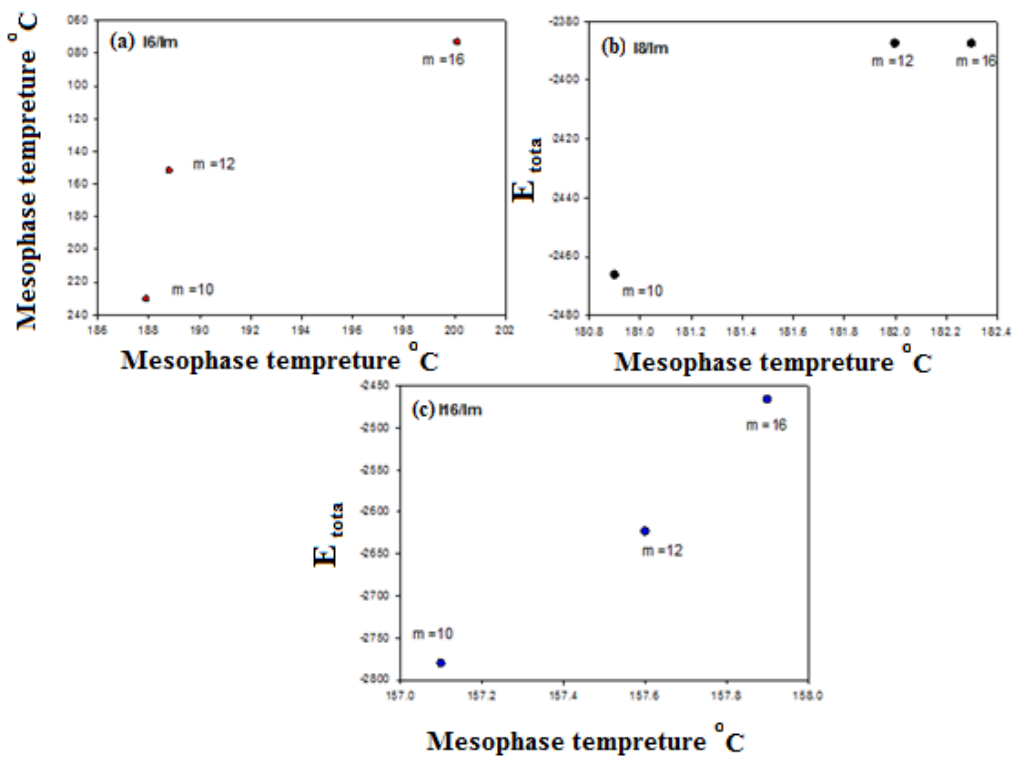
Figure 7. Relationship between the sum of the electronic and thermal energies of H-bonded complexes An/Im ; ( a ) n = 6 ; ( b ) n = 8 and ( c ) n =